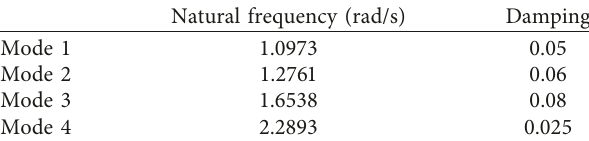
Table 1: Parameters of the flexible dynamics.